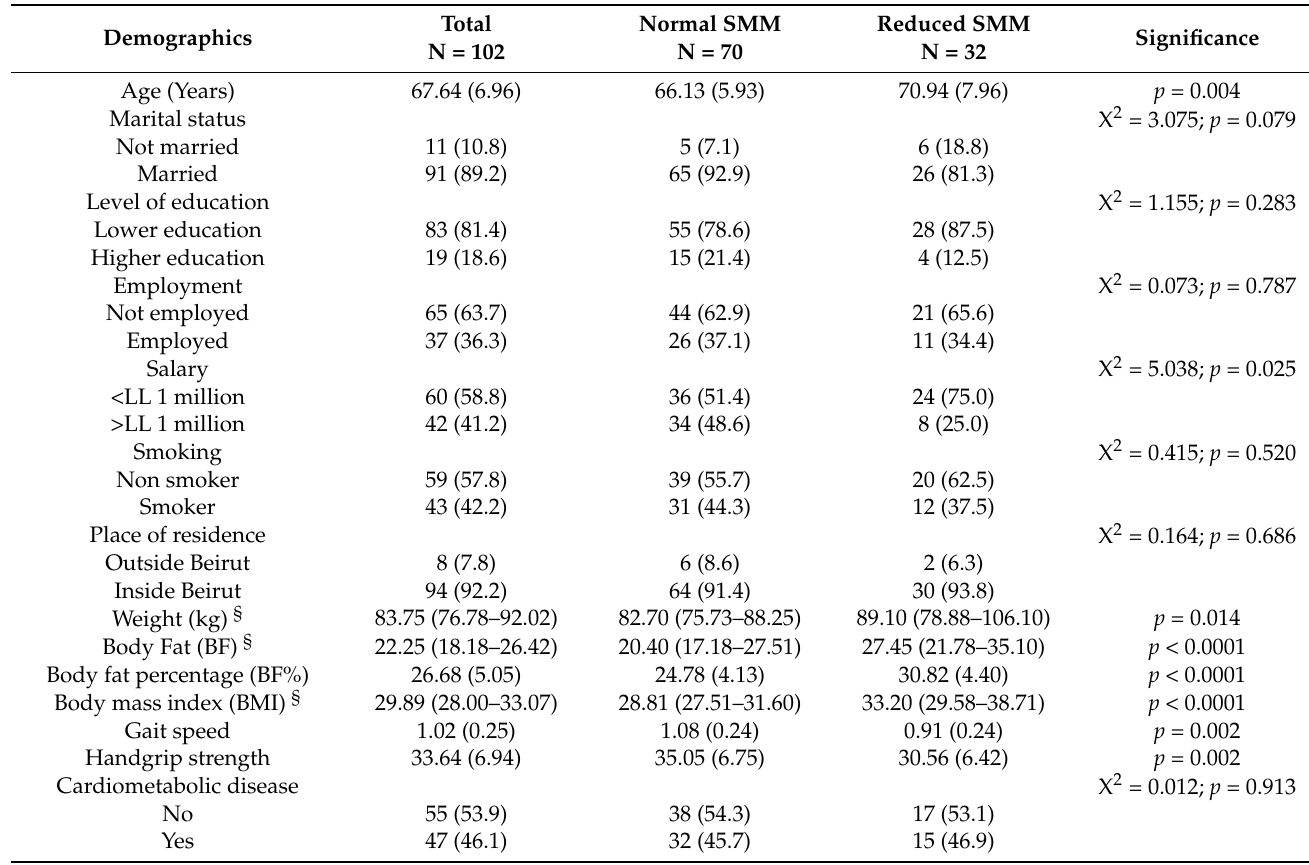
Table 1. Socio-demographic, anthropometric and cardiometabolic characteristics of the study sample (n = 102).